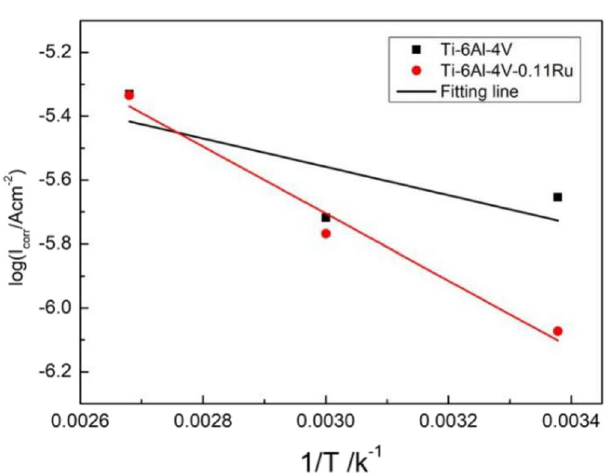
Figure 15. Schematic diagram of the influence model of Ru on the passive film thickness and structure of Ti-6Al-4V alloy ( a ) without Ru and ( b ) Ru-containing (Note: the locations of O, Ru and H 2 O are arbitrary).